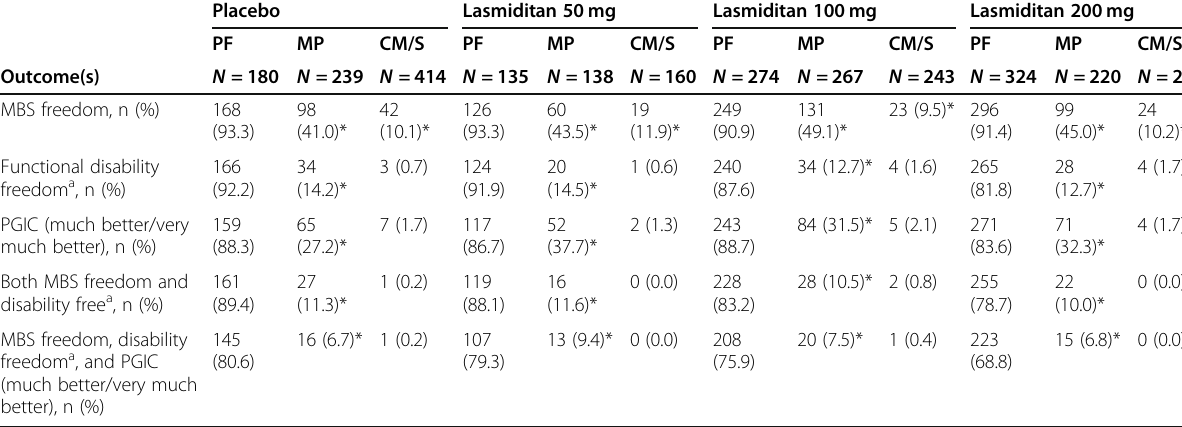
Table 4 Proportion of patients with additional outcomes at 2 h by treatment and head pain groups Placebo Lasmiditan 50